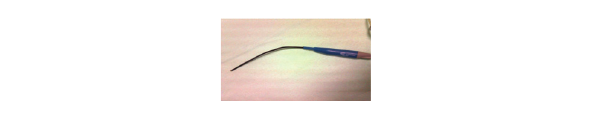
Laryngeal blade of radiofrequency used in this